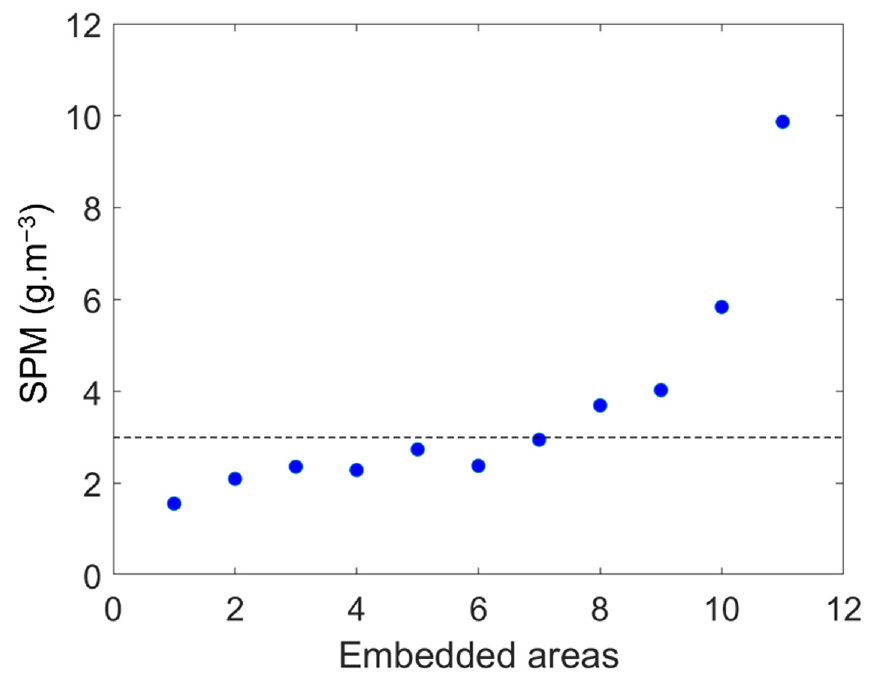
Figure A6. Percentile 95 values of SPM concentration (g.m − 3 ) for the twelve embedded areas. The shaded line corresponds to a concentration of 3 g.m − 3 and is considered to be the limit between the SPM concentration background and the SPM concentration of the turbid plume.